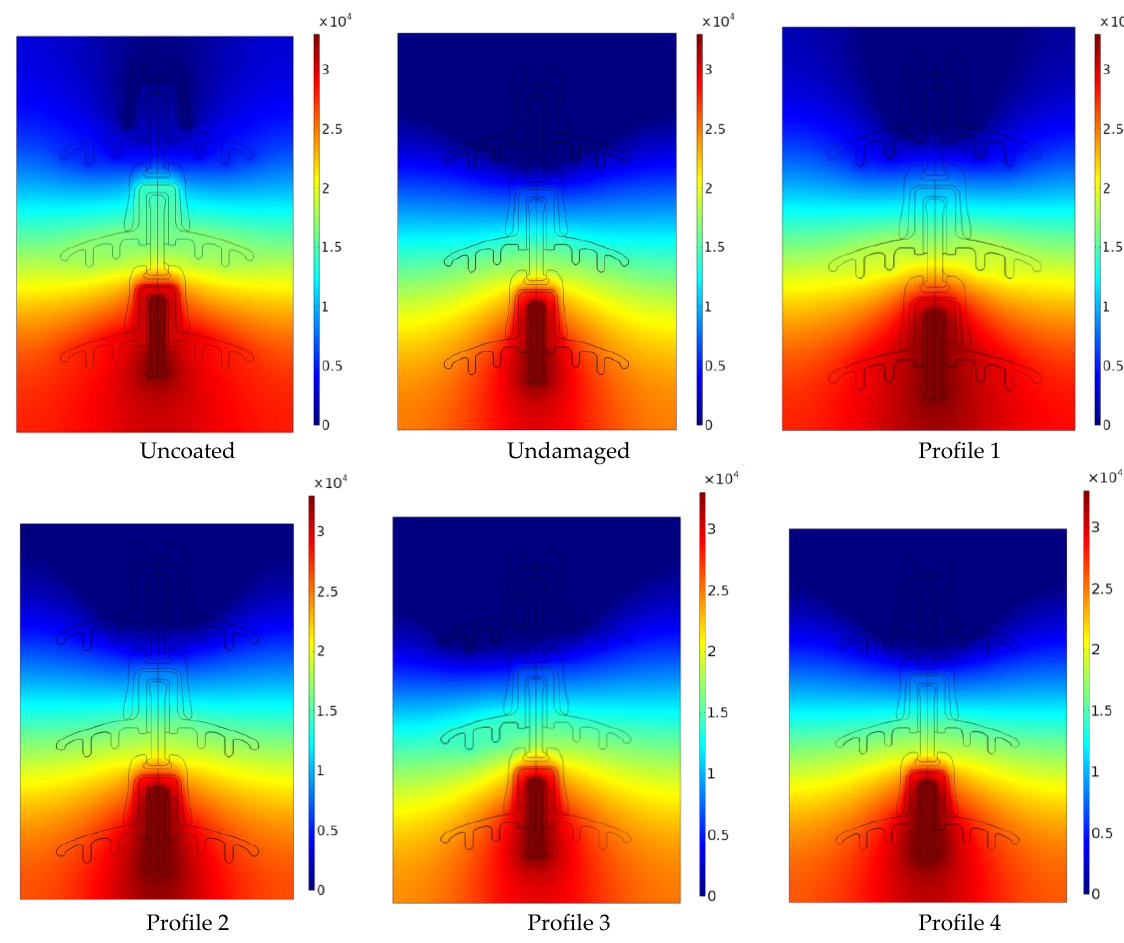
Figure 12. Electric potential distribution of insulators with different RTV coating damage profiles.